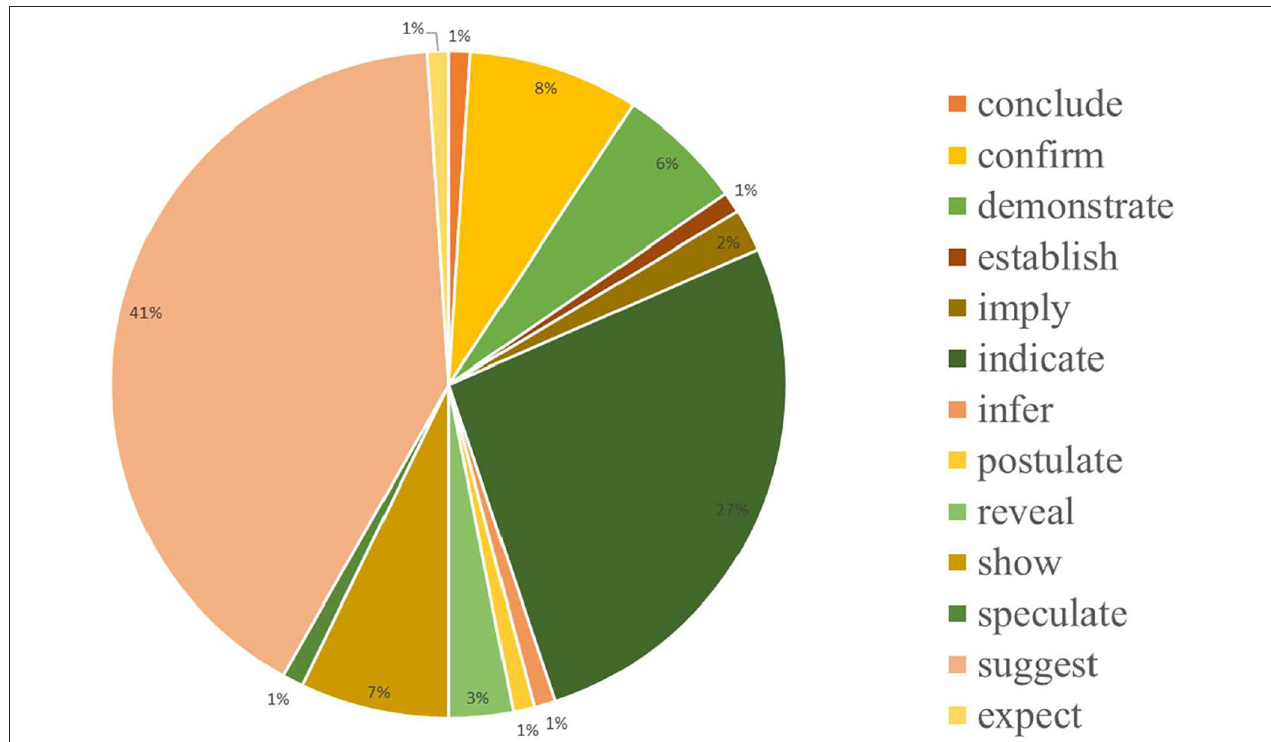
FIGURE 1 | Frequency of verbs